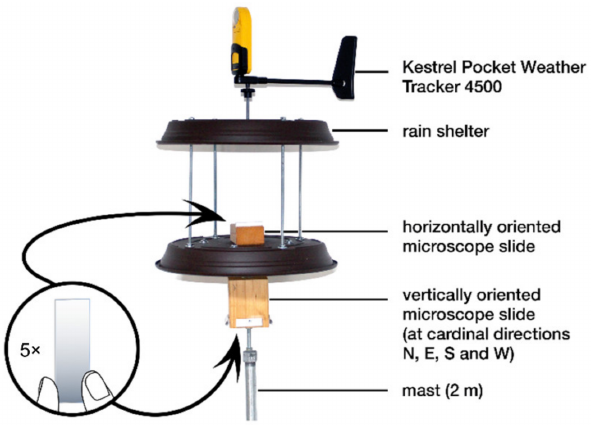
Figure 4. Gravimetric pollen trap used in this